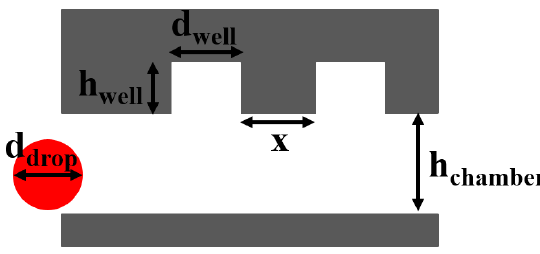
Figure 6. Device design parameters for efficient droplet trapping and recovery. Table 1. Performance metrics of the Floating Droplet Array (FDA) device. Device performance was analyzed using four different FDA devices to trap a single droplet per well. Droplet coverage (percentage of occupied wells), droplet recovery (percentage of droplets recovered after trapping), and capture efficiency (percentage of droplets trapped relative to total droplets generated) were quantified based on analysis of >1000 wells for each group.